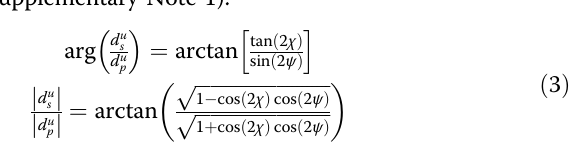
Fig. 5a illustrates a twisted PhCS having rotation of top hole and bottom hole with relation α states have the same value of χ (Fig. 5b, c for the upward and Fig. 5d, e for the downward radiation), and the polarization orientation angle keeps the charge of 1 (detailed in the Supplementary Material).